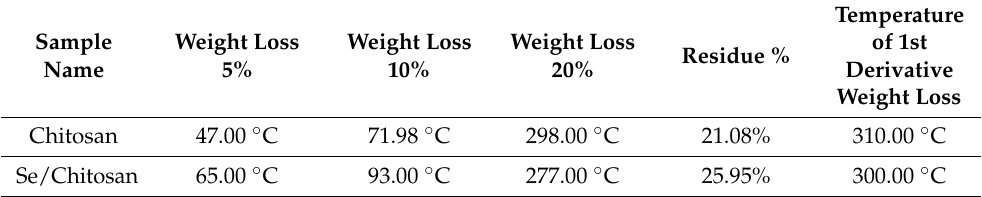
Table 1. Thermal behavior of chitosan and its derivatives.